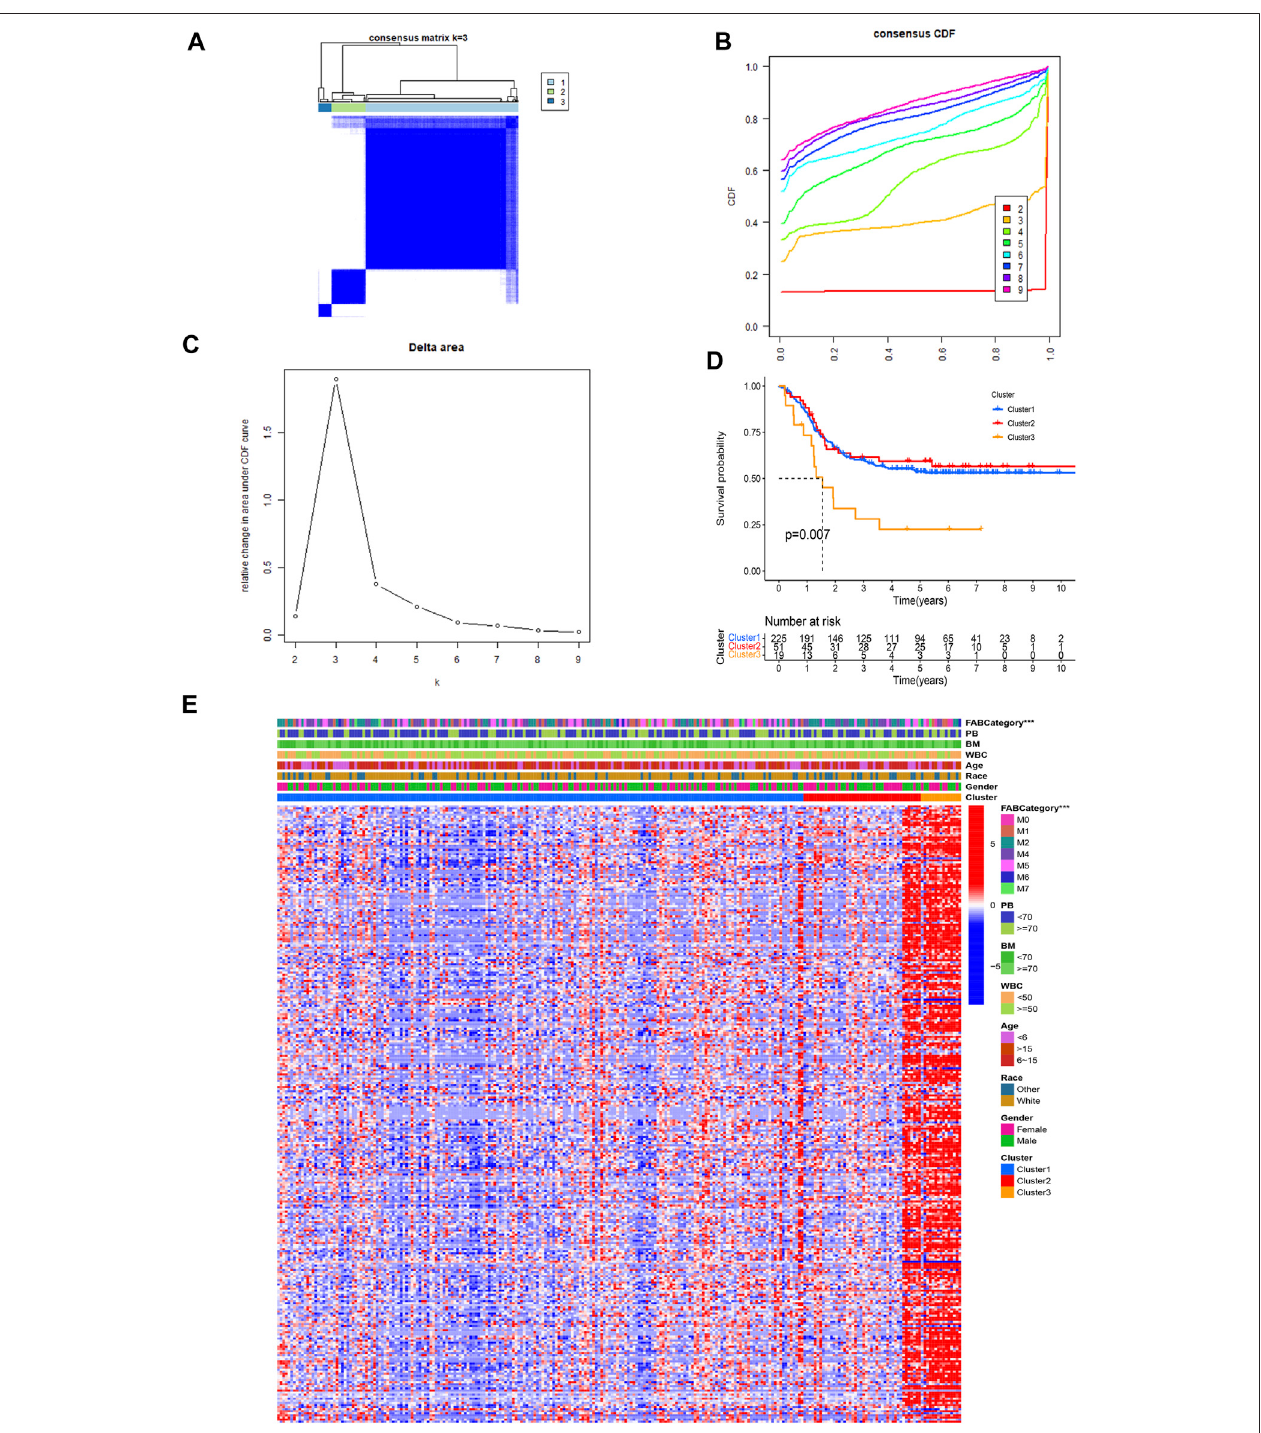
FIGURE 2 | Consensus clustering of m6A-related genes and differential analysis ofdifferent factors among different clusters. (A) Consensus clustering matrix for k = 3. (B) Cumulative distribution function (CDF) for AML. Choose the curve with a smaller CDF descent slope among the curves with horizontal coordinates ranging from 0.1 to 0.9. (C) Area under the CDF curve in AML. Choose the cluster k whose CDF decreases less drastically and whose CDF value cannot be too small. (D) Kaplan – Meier curves of the overall survival for patients with AML in three clusters (OS). (E) Heatmap and clinicopathological characteristics of AML subgroups classi fi ed by 315 genetic prognostic